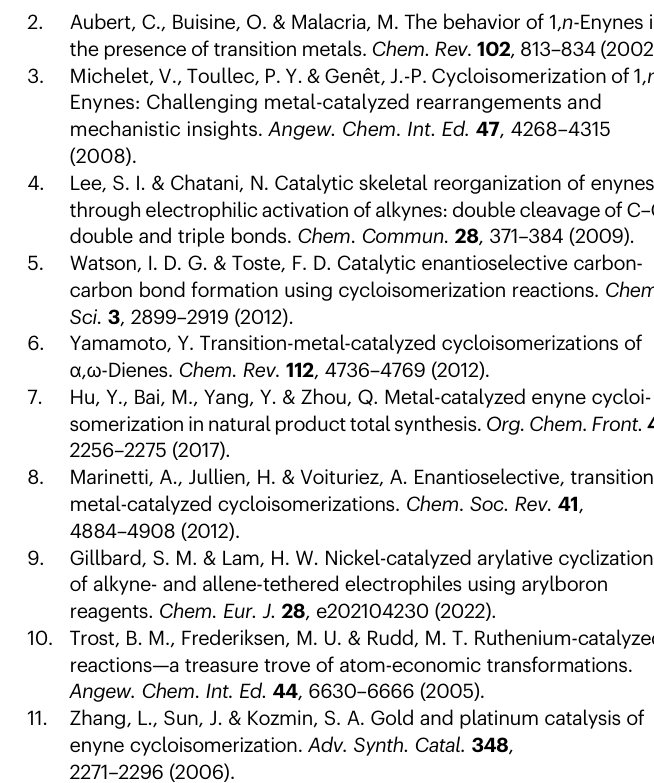
Fig. 5 | Gibbs energy pro fi le for Pathway I and Pathway II. All calculations were performed at the SMD(acetonitrile)-M06L/6-311+G(d,p)-SDD(Co)//M06L/6-31G(d)- SDD(Co) level. a Gibbs energy pro fi le for Pathway I. b Gibbs energy pro fi le for Pathway